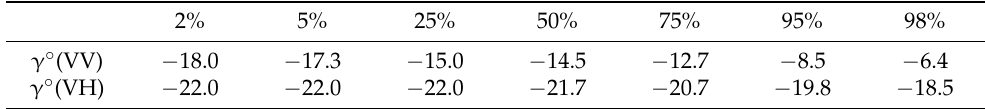
Table 2. Land–water threshold values for γ ◦ (VV) and γ ◦ (VH) backscatter for the percentile images at second, fifth, 25th, 50th, 75th, 95th, and 98th